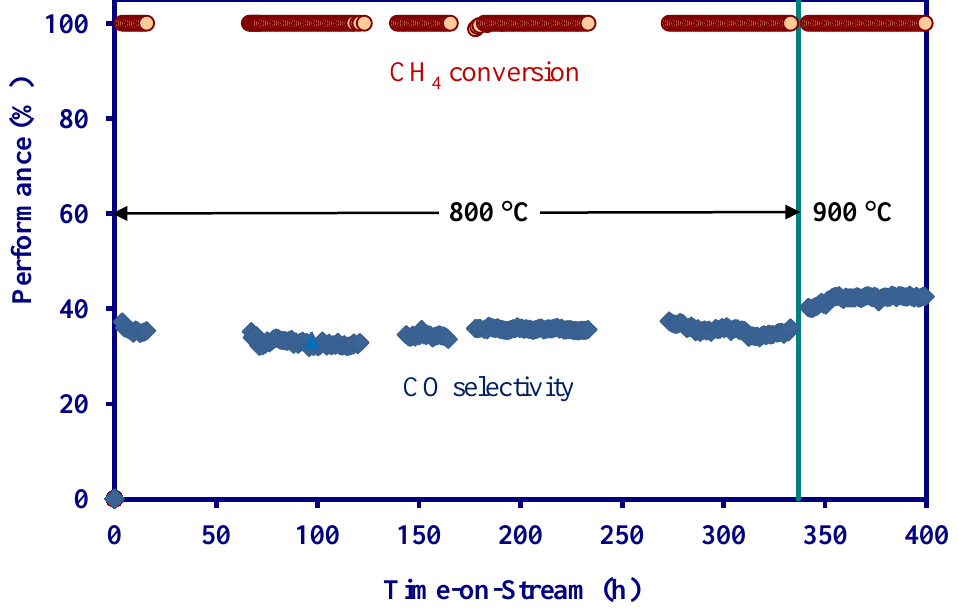
Figure 3. Reforming of biomass gasification products on MNS catalyst under the conditions of 3.7% H GHSV = 24,000 mL/g/h.